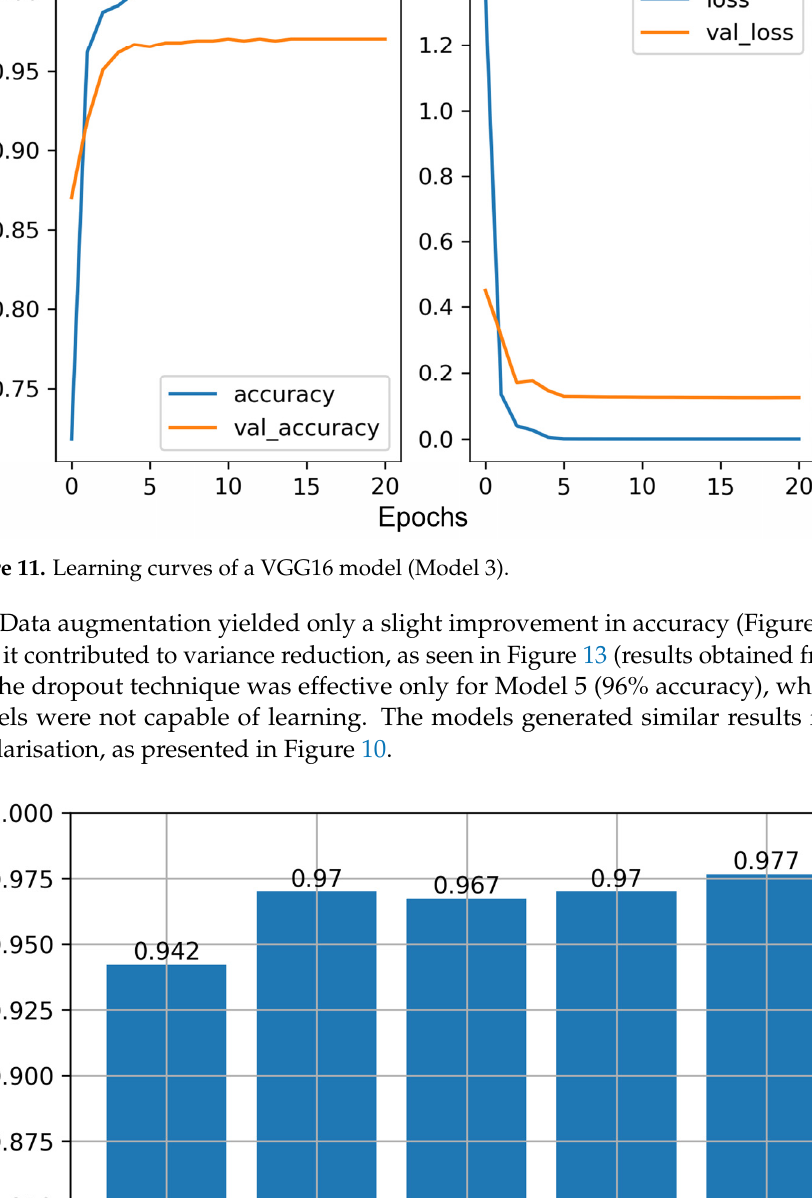
Figure 10. Accuracy of VGG16 models.